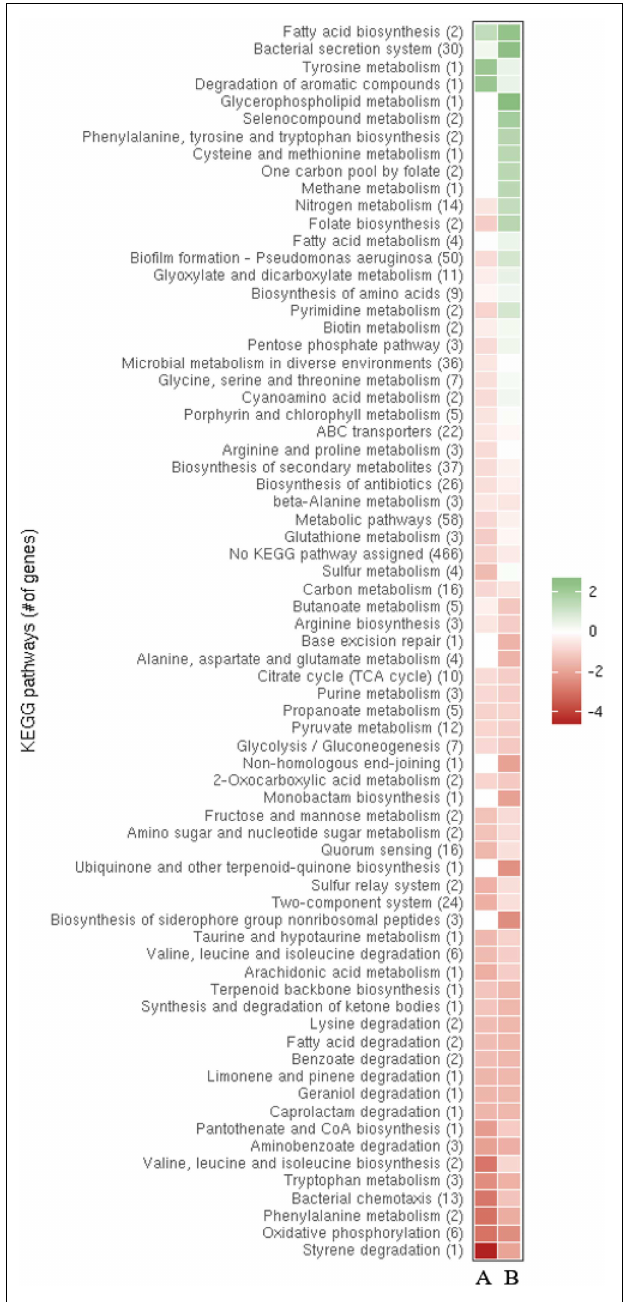
FIGURE 1 | Meta-analysis of normalized expression of differentially abundant transcripts in strains PAO1 (cid:49) reaL (pKH6-ReaL) versus PAO1 (cid:49) reaL (pKH6) and strains PAO1D rpoS versus PAO1 (Schuster et al., 2004). The genes are grouped into the corresponding pathways (http://www.kegg.jp/kegg-bin/show_organism?org~=~pau). The columns denote PAO1 (cid:49) reaL (pKH6-ReaL) versus PAO1 (cid:49) reaL (pKH6) (A) and PAO1 (cid:49) rpoS versus PAO1 (B) , respectively. The color code shown in the scale at the right denotes log 2 -fold changes and fold change for the RNA Seq -based analysis, and the microarray-based analysis, respectively. Red indicates an overall decrease and green indicates an overall increase in the transcript levels of genes in a particular pathway. The numbers of genes within each pathway are indicated by the numbers given in parenthesis.